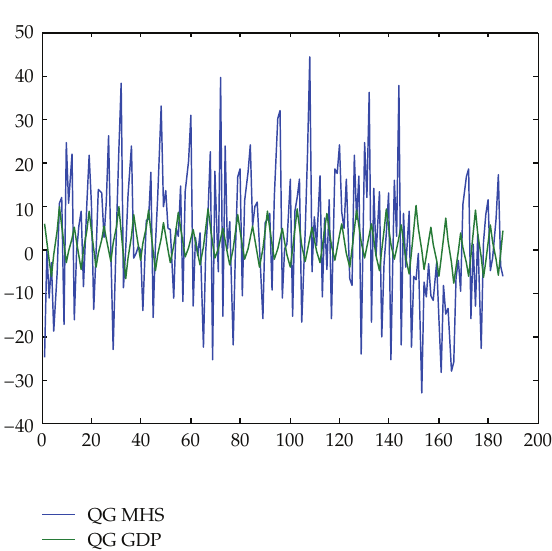
Figure 11: Quarterly growth rates MHS and GDP.